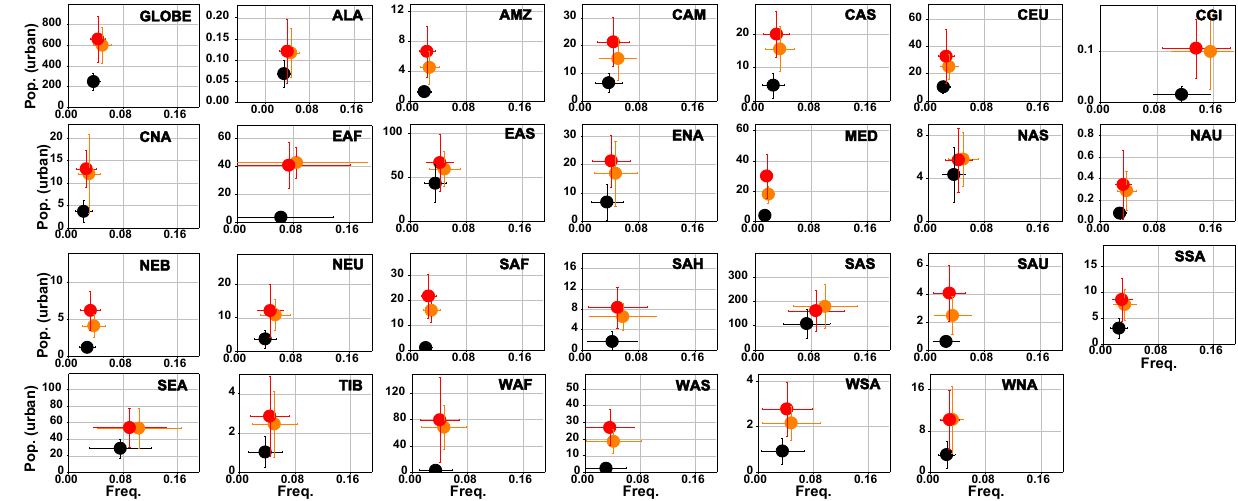
Figure 12. Multi-model projected frequency (Freq.) and affected urban population (Pop., in millions) by severe drought (PDSI < − 3) globally and in 27 regions for the baseline period (black, fixed SSP1 2000 population) and the 1.5 ◦ C (orange, fixed SSP1 2100 population) and 2 ◦ C (red, fixed SSP1 2100 population) warmer worlds. The projected uncertainties (standard deviation of multiple-model results) of multiple climate models are shown by error bars (horizontal and vertical).